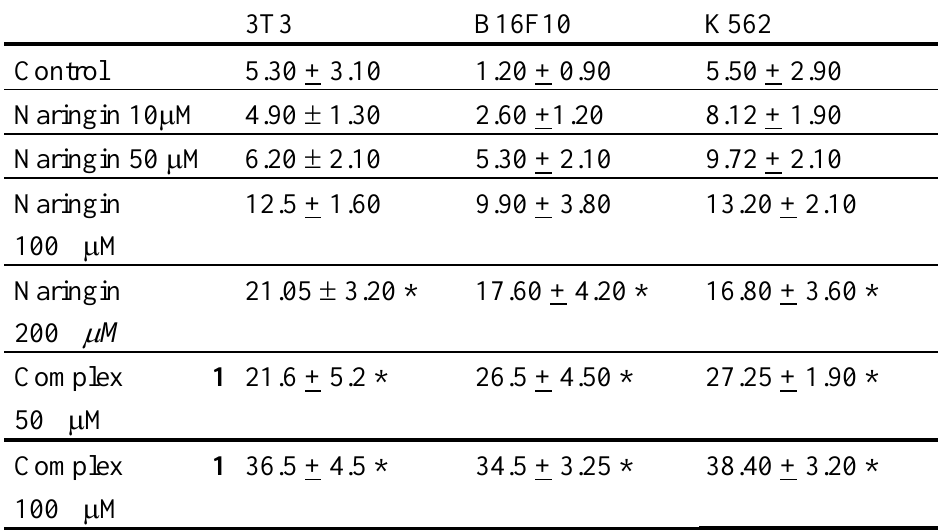
Table 5. Cell death (%) of several cell lines in culture after 24h exposure to